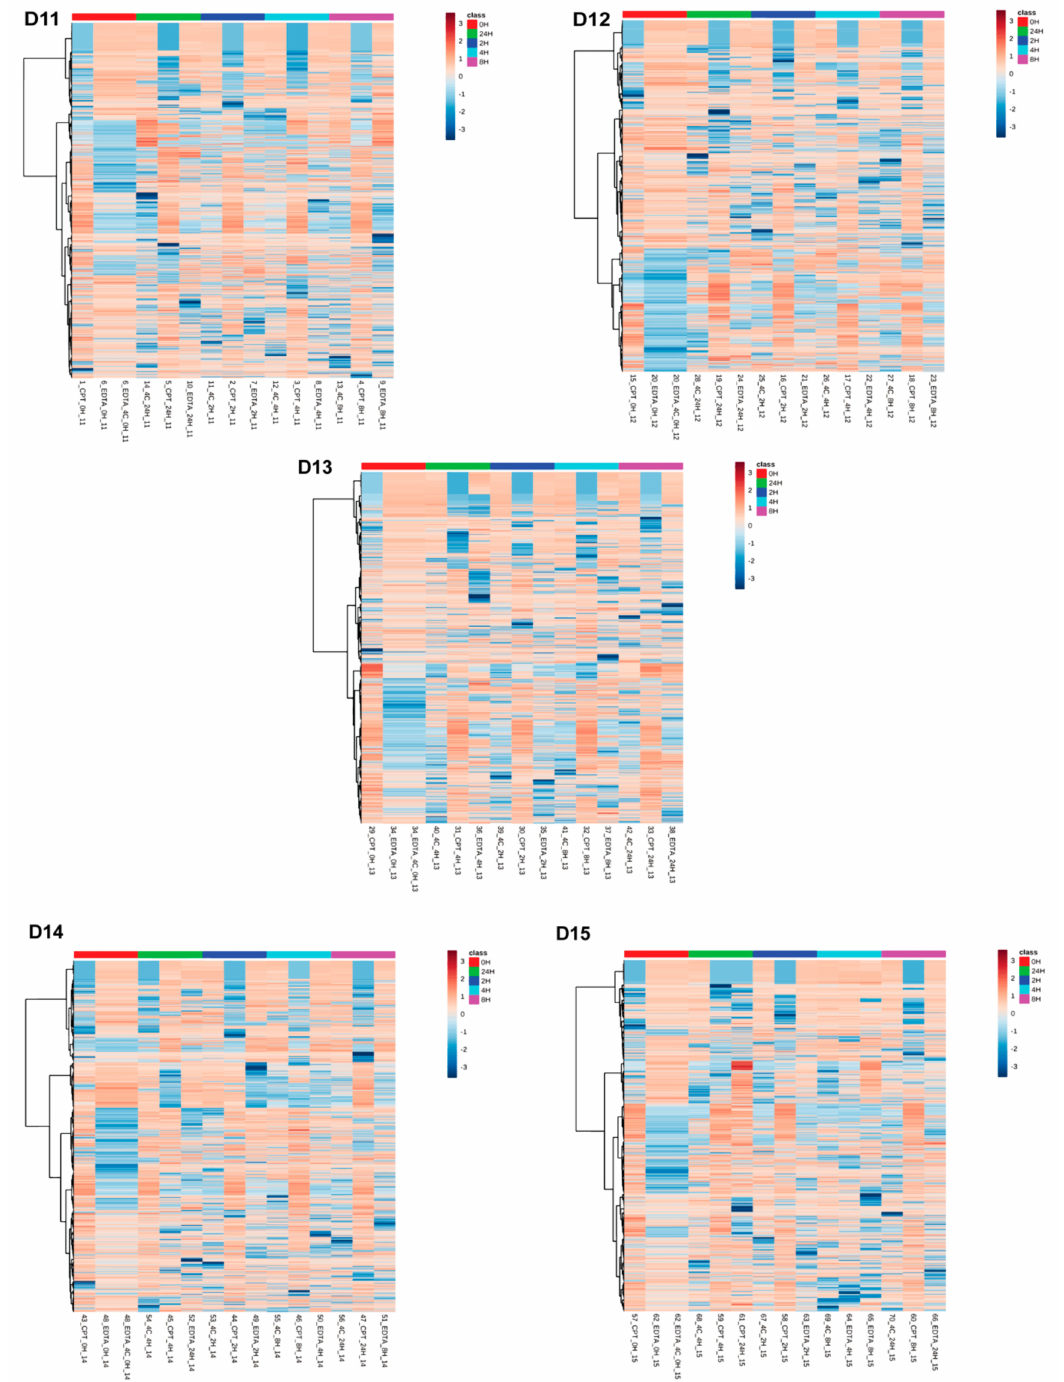
Figure 8. Two-way hierarchical clustering analysis using Euclidean distance and ward.D clustering algorithm among donor-matched samples grouped by storage time. The heatmap shows overall metabolite profile differences in negative ionization mode grouped by storage time in donor-matched